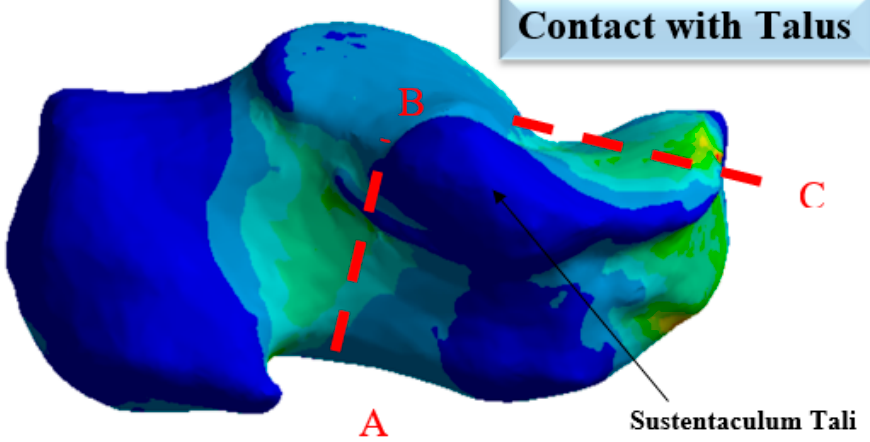
Figure 14. The most likely fracture lines of a healthy heel bone.